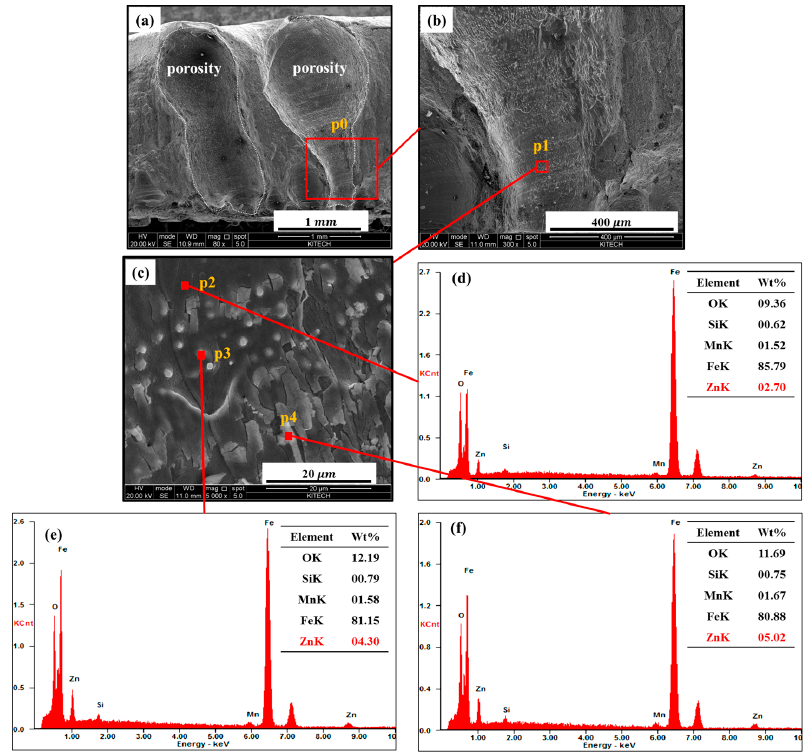
Figure 5. EDS analysis of porous locations in the welded section: ( a ) 80× image of the welded cross section; ( b ) 300× image at point p0; ( c ) 5000× image at point p1; EDS component analyses at ( d ) point p2, ( e ) point p3, and ( f ) point p4. Metals 2018 , 8 , x FOR PEER REVIEW